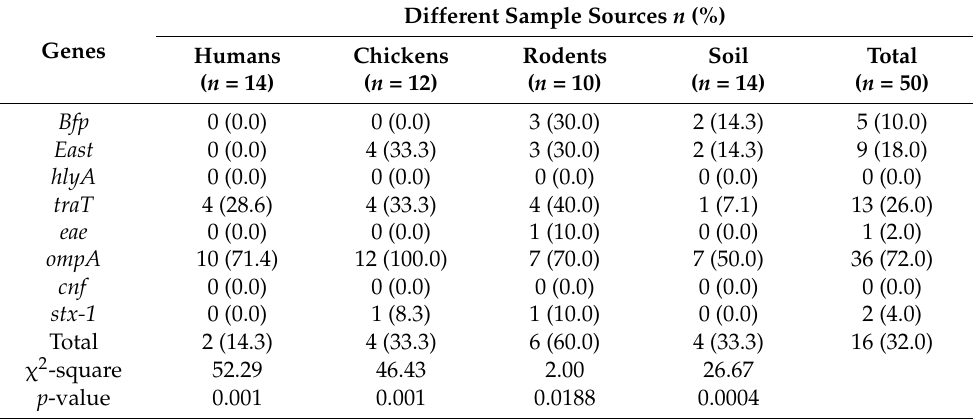
Table 1. Detection of virulence genes of MDR E. coli isolates from different sample